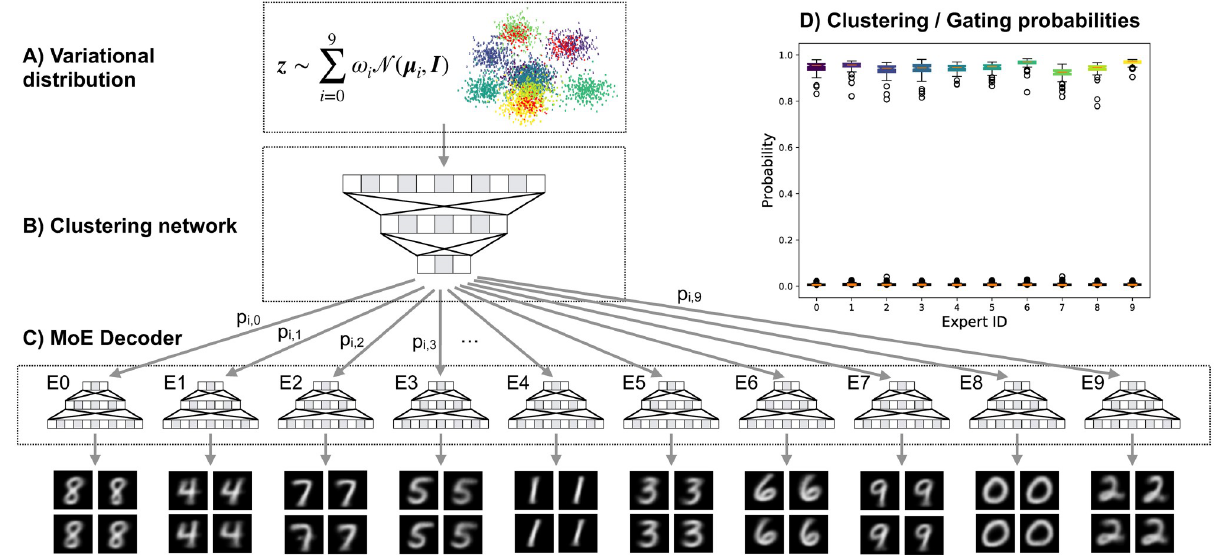
Fig 2. Generation of MNIST digit images. Data points from the latent representation were sampled from the variational distribution (A) which is learned to be a mixture of standard Gaussians and then clustered and gated (B) to the data-mode-specific experts of the MoE Decoder (C). (D) All samples from the variational distribution were correctly classified and therefore also correctly